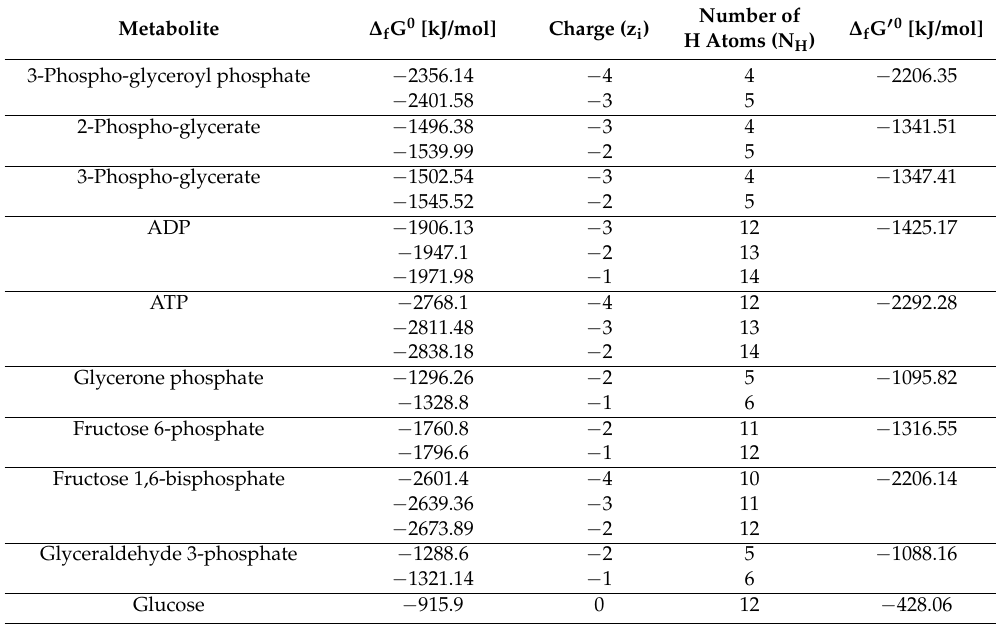
Table 1. Standard transformed Gibbs energy for metabolites involved in